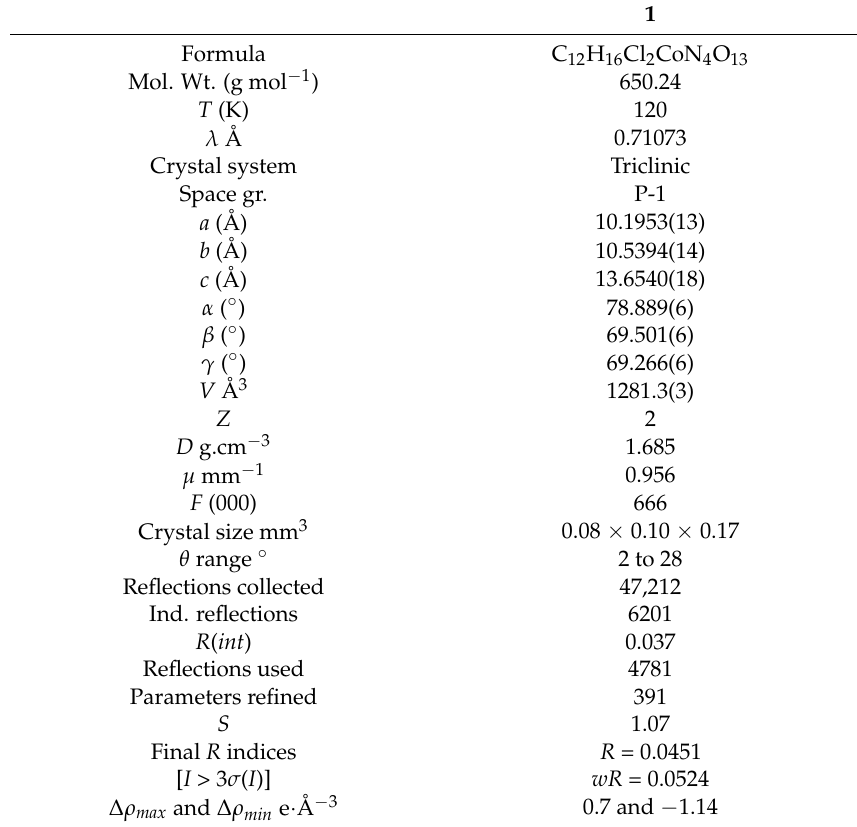
Table 4. Crystal Data of compound 1